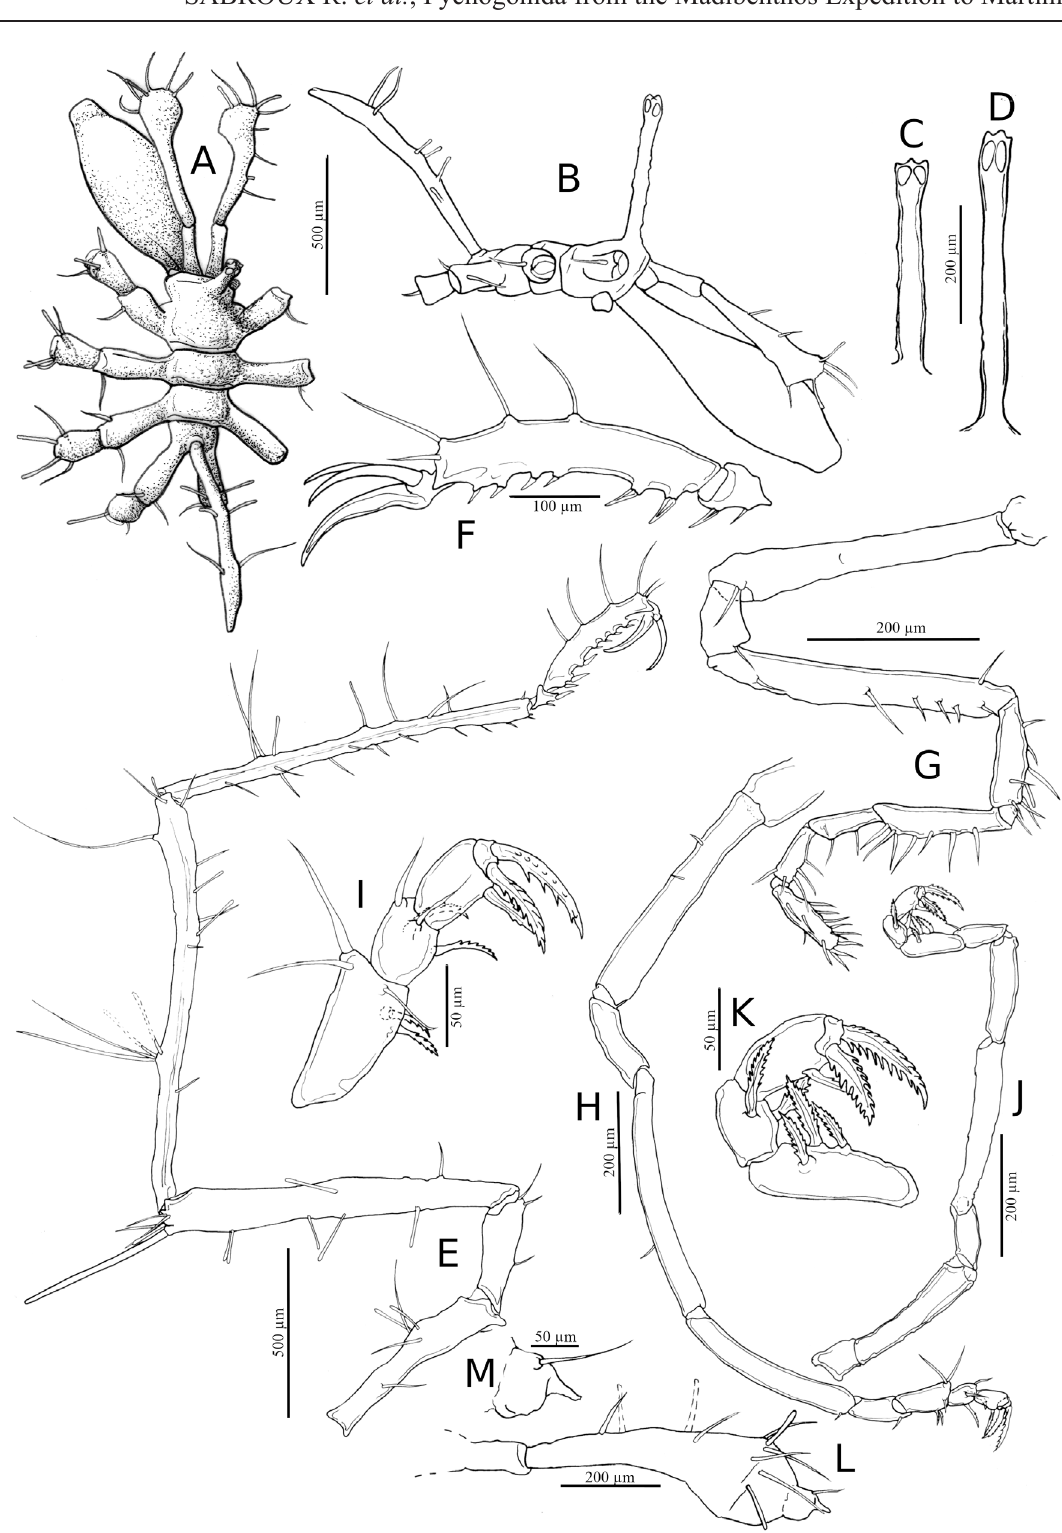
Fig. 4. Ammothella aff. krappi sp. nov. A–B, D–I, L–M . ♂, MNHN-IU-2019-3400. C . Juvenile, MNHN-IU-2016-834. J–K . ♀, MNHN-IU-2016-1316. A . Body, dorsal view. B . Body, lateral view (same scale as A). C . Ocular tubercle, frontal view. D . Ocular tubercle, frontal view. E . Fourth leg. F . Tarsus and propodus of fourth leg. G . Palp. H . Oviger. I . Oviger strigilis. J . Oviger. K . Oviger strigilis. L . Chelifore. M . Close-up of chela